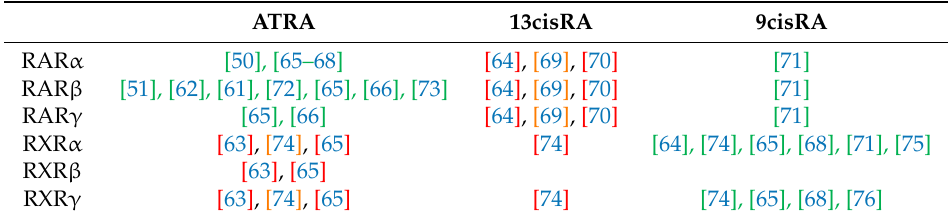
Table 1. Literature report of the interactions of different RAs with their receptors (green: an interaction is highlighted, orange: no interaction is highlighted, red: a lack of interaction is highlighted). ATRA 13cisRA